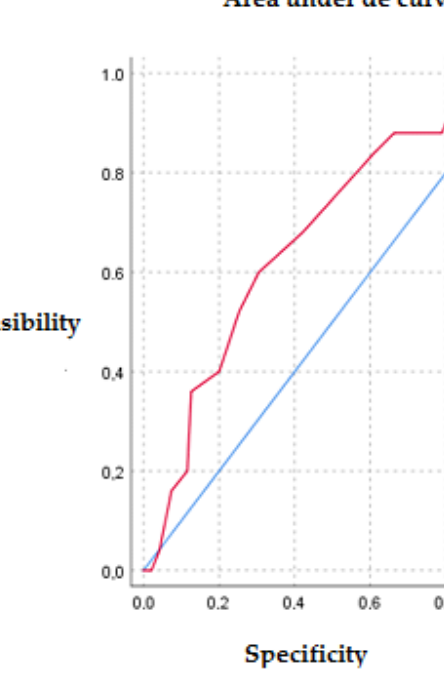
Figure 2. ROC curve of IVC diameter and 30-day mortality for patients with more than 6 B lines on lung ultrasound.